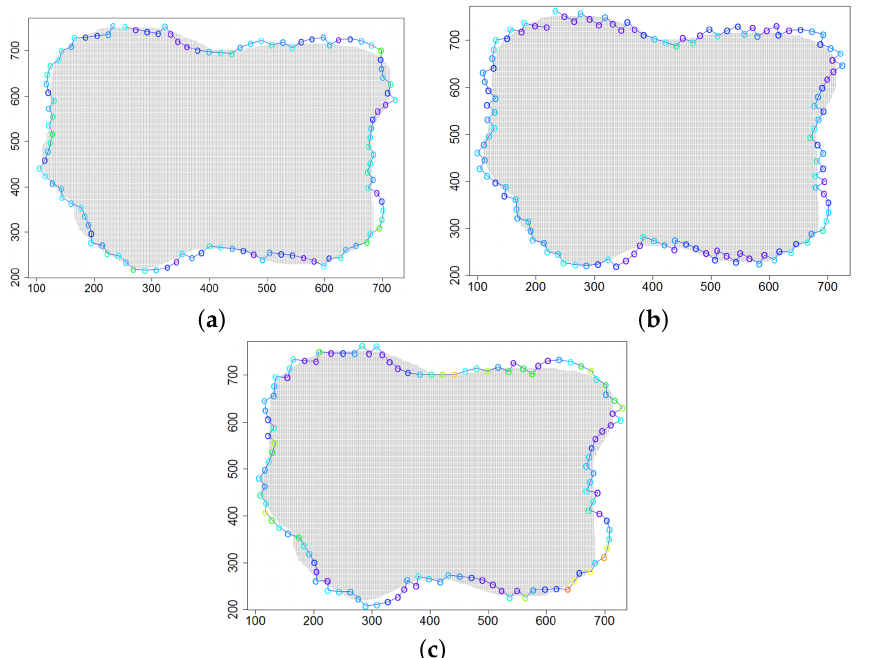
Figure 11. Successive D P positions during cloud boundary tracking calculated for three variants of m (cid:101) χ updating procedures: ( a ) variant III, ( b ) variant IV, ( c ) variant V; simulation scenario Cloud 4 . The colors of the points correspond to different values of (cid:101) χ